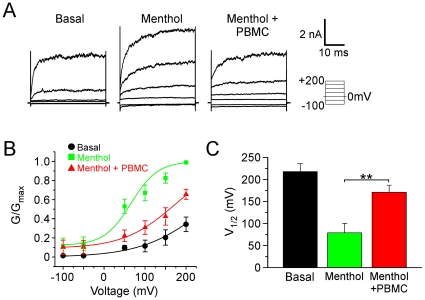
PBMC shifts the voltage dependence of TRPM8 channel gating.
A) Representative whole-cell TRPM8 current traces in response to the indicated voltage step protocol. Traces show activity before and after application of 1 mM menthol and after application of 0.5 nM PBMC while still in the presence of 1 mM menthol. B) Steady-state activation curves under basal, menthol, and menthol + PBMC conditions. The normalized conductance (G/Gmax) was plotted against voltage and the addition of PBMC resulted in a reduction of the normalized conductance. Lines represent Boltzmann functions fitted to the data (n = 6–8 cells). C) Average voltages (mV) of half-maximal normalized conductance (V1/2) obtained from the Boltzmann functions in B. The addition of PBMC with menthol shifted the V1/2 from 79.1±21.1 mV to 171.2±16.0 mV (Student's t-test, **p<0.01), towards the baseline value of 218.2±18.2 mV.